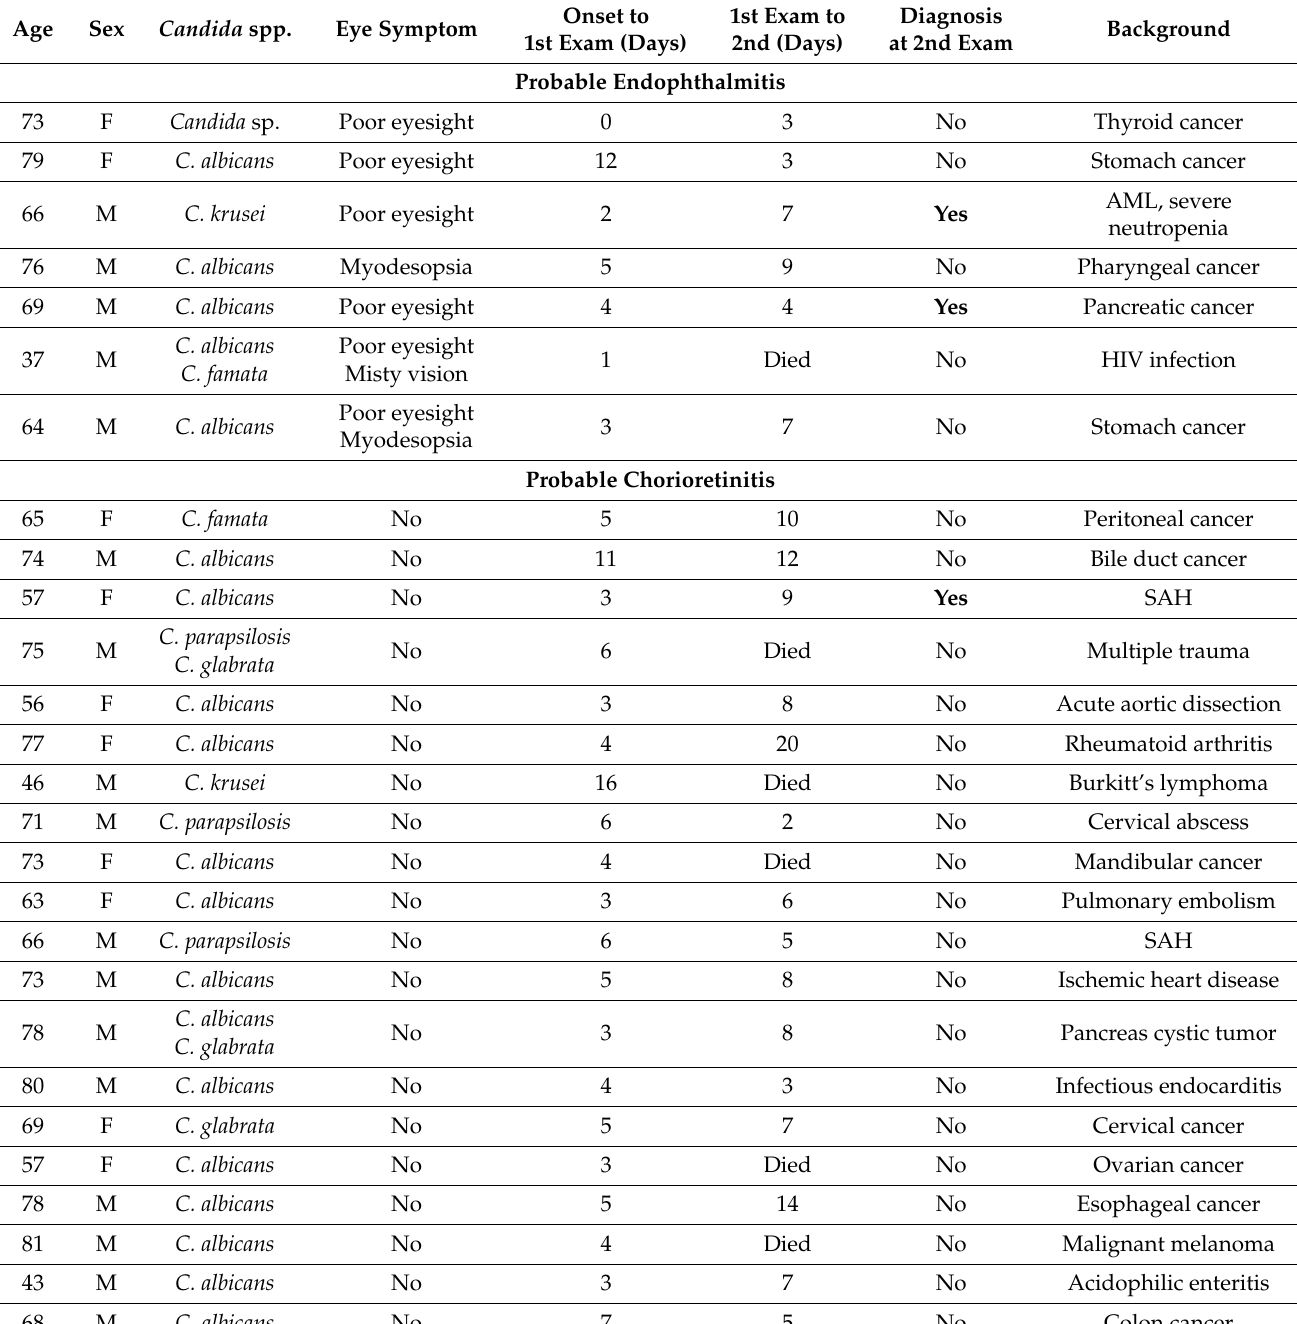
Table 1. Characteristics of patients with ocular candidiasis and the intervals of ophthalmologic